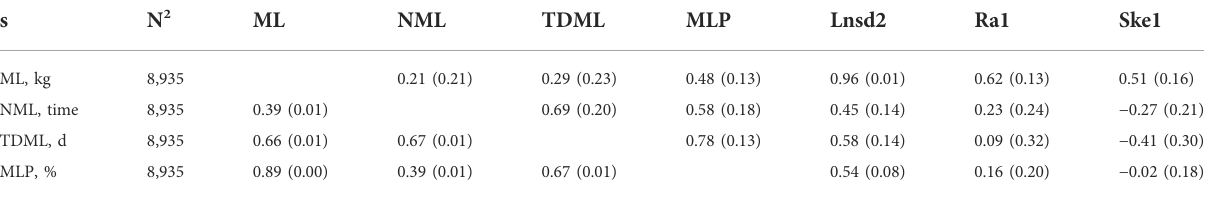
TABLE 4 Genetic and phenotypic correlations among milk loss traits and genetic correlations between milk loss traits and variability traits.